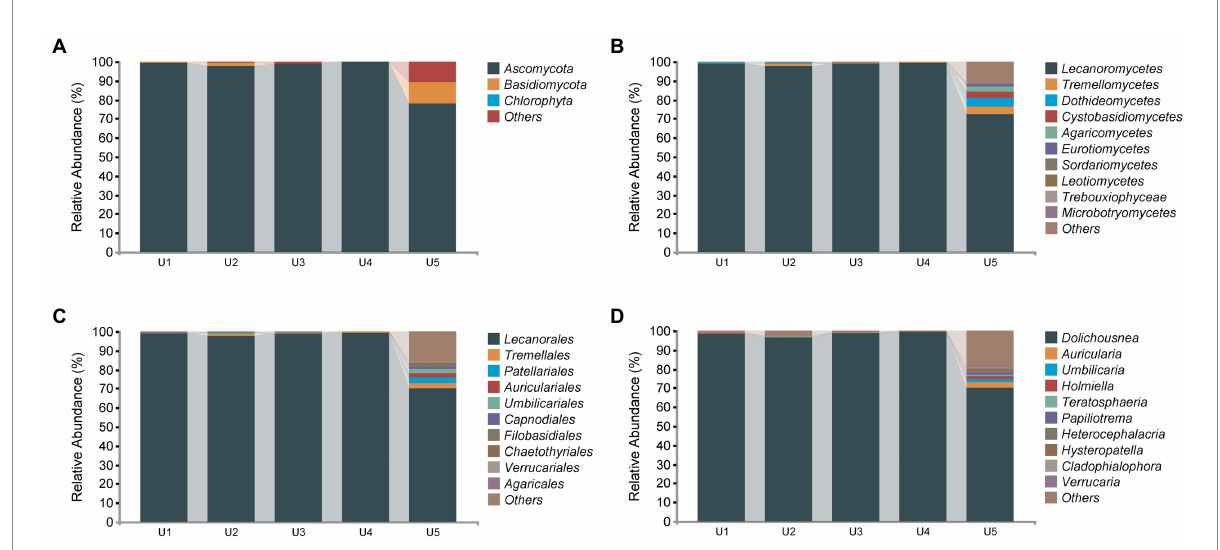
FIGURE 4 Relative abundance distribution of endophytic fungal communities in Usnea longissima . (A–D) The relative abundance that are distributed at the phylum, class, order, and genus levels,